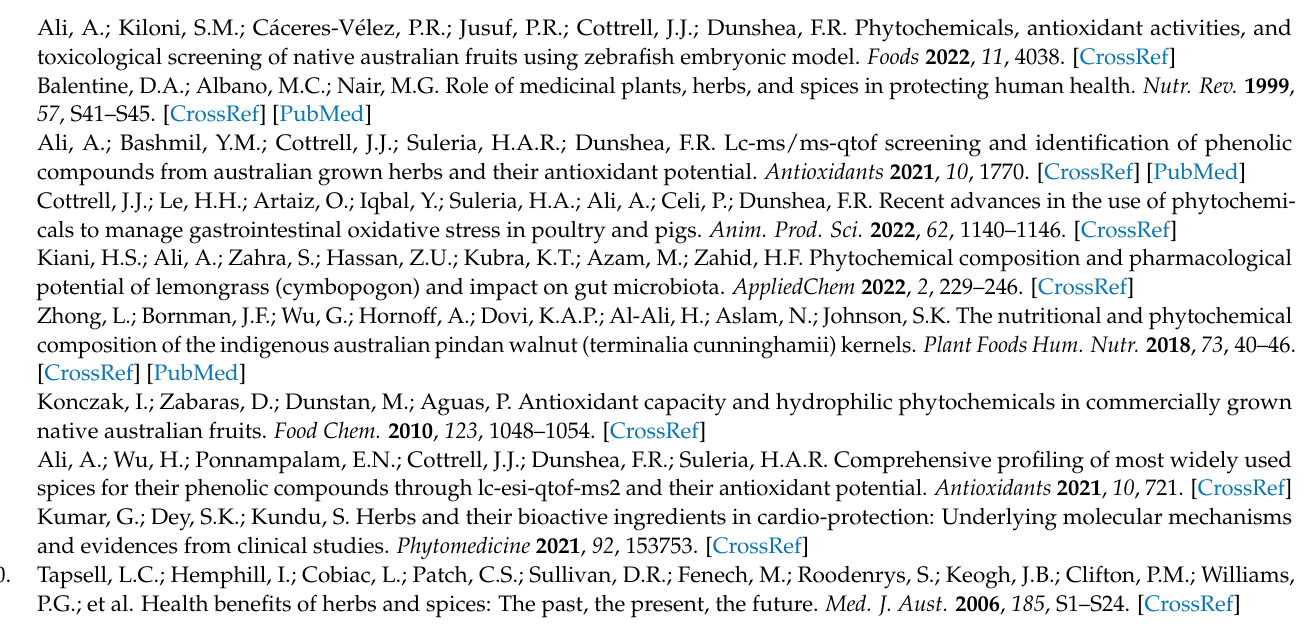
Table S1: Phenolic contents in Australian native herbs and fruits and their antioxidant activities; Table Table S3: Predicted absorption and distribution of selected compounds; Table S4: Pharmacokinetics properties of selected compounds; Table S5: Radar bioavailability properties of selected compounds; Table S6: Predicted metabolism and excretion of selected compounds; Table S7: Predicted toxicity of abundant phenolic